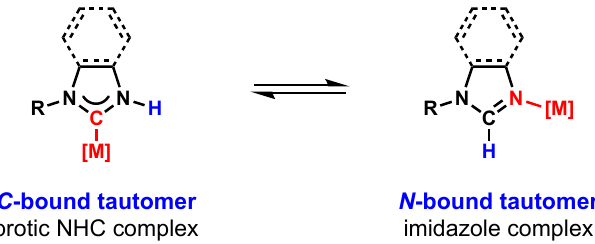
Scheme 1. Tautomeric forms of imidazole-based protic metal NHC complexes.